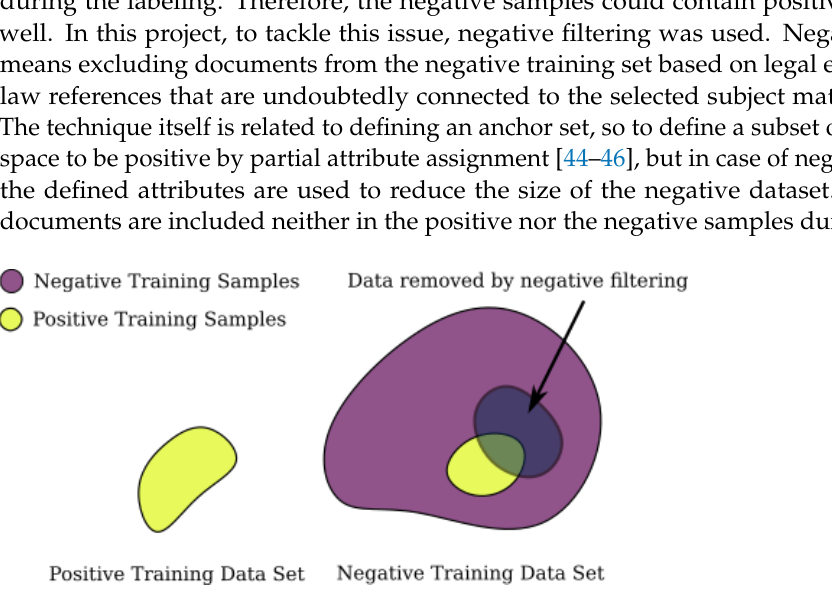
Figure 2. Negative filtering to reduce positive label contamination in the negative training